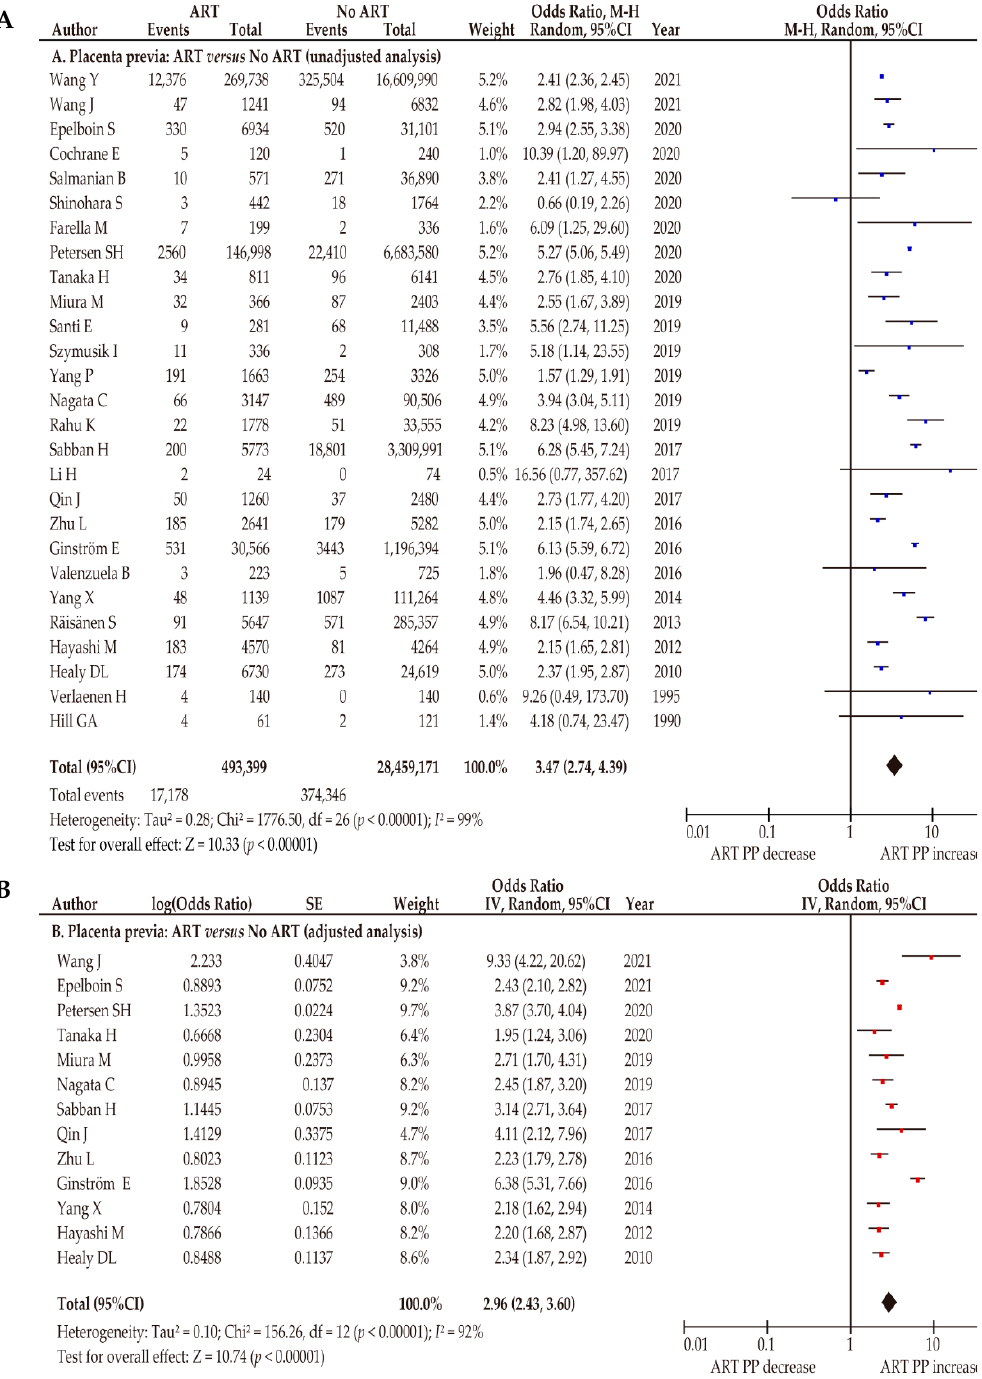
Figure 3. Effect of assisted reproductive technology on the prevalence of placenta previa. The pooled odds ratios (ORs) for the ( A ) unadjusted analysis of placenta accreta spectrum disorder (PASD) and ( B ) adjusted analysis of placenta previa for women who conceived using ART and women who conceived without ART. Forest plots were ordered within the stratum by relative weight (%) and the publication year of the study. Considerable heterogeneity was observed during the unadjusted analysis ( A : I 2 = 99%) and during the adjusted analysis ( B : I 2 = 92%). Some values might be slightly different from the original values, because the calculations were performed using RevMan ver. 5.4.1. Abbrevi- ations: ART, assisted reproductive technology; PP, placenta previa; OR, odds ratio; CI, confidence interval; SE, standard